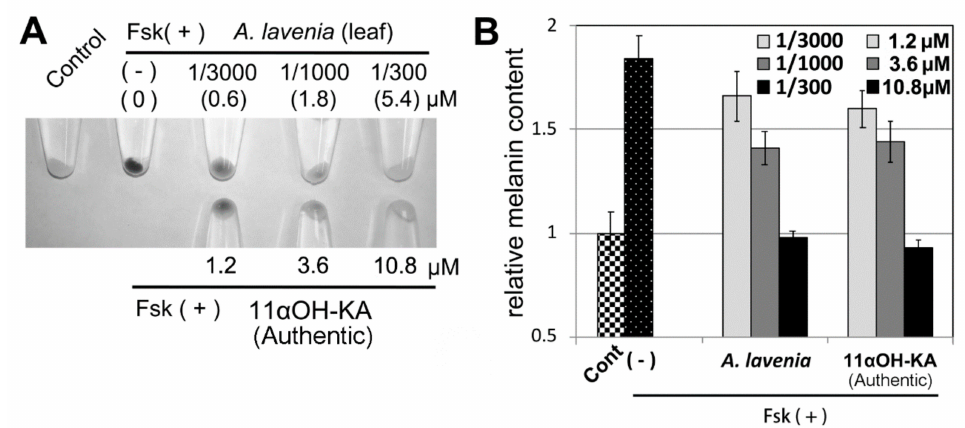
Figure 4. ( A ) A. lavenia leaves were extracted with 30 volumes of water and incubated at 120 ◦ C for 20 min. After measurement of the 11 α OH-KA content in the extract, the extracts (upper: actual concentrations of 11 α OH-KA from the extract are indicated in brackets) and authentic 11 α OH-KA with a 1 / 10–10-fold concentration were subjected to a melanogenesis inhibitory assay in the B16F10 cells. By visual examination, we selected sets of cells showing the same levels of melanin content (lower). ( B ) The melanin content in the A: extract and authentic samples was thus measured. The means and SD are indicted, n = 3.